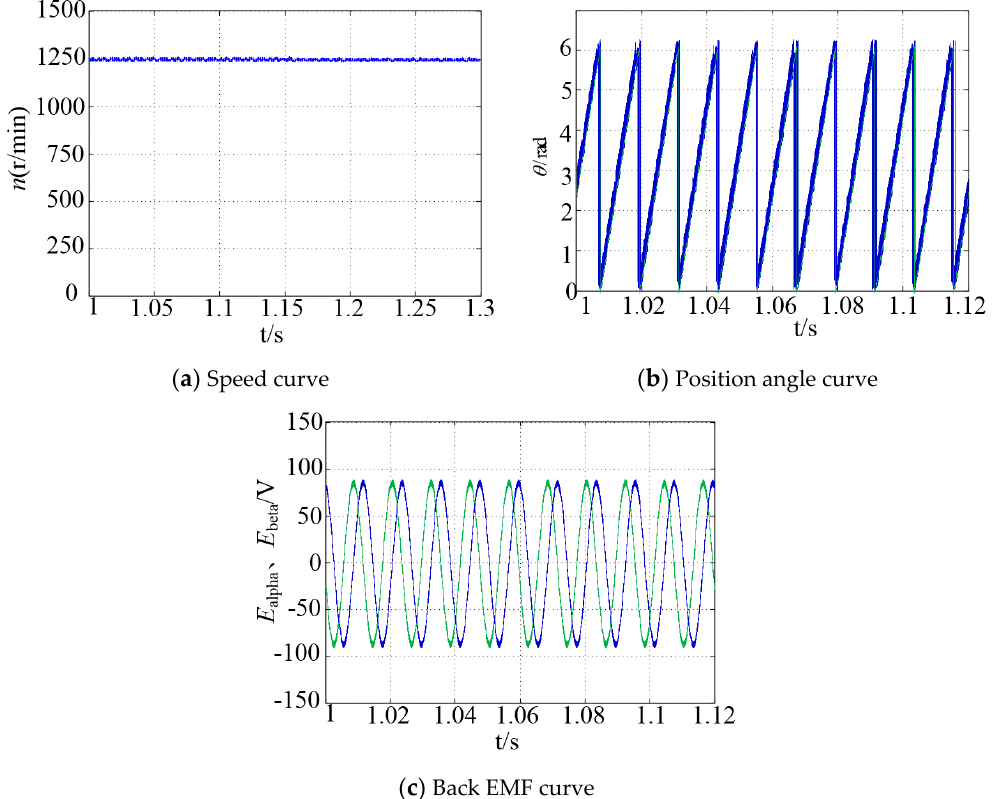
Figure 6. Simulation curves of steady state of the conventional sliding mode observer (CSMO).